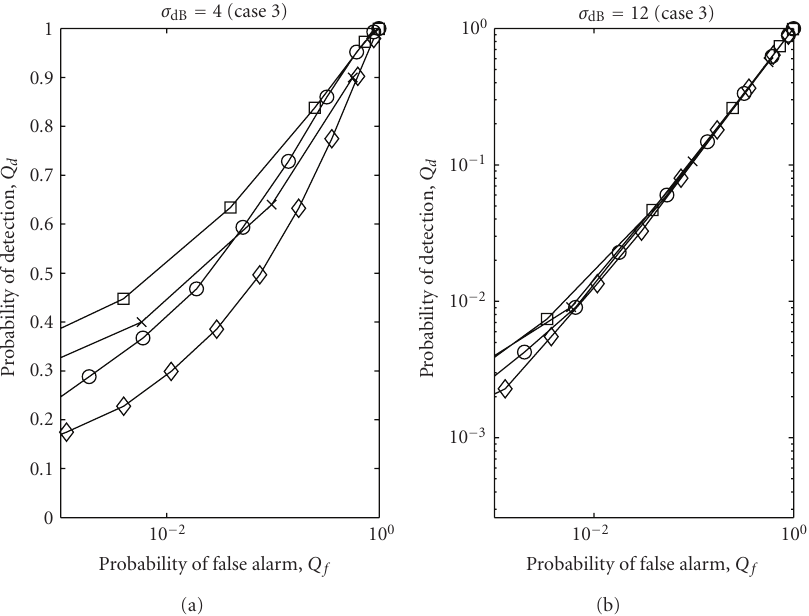
Figure 12: Receiver operating characteristics for 5 collaborating users in spatially correlated shadowing fading (Case 3: only one user has high SNR).